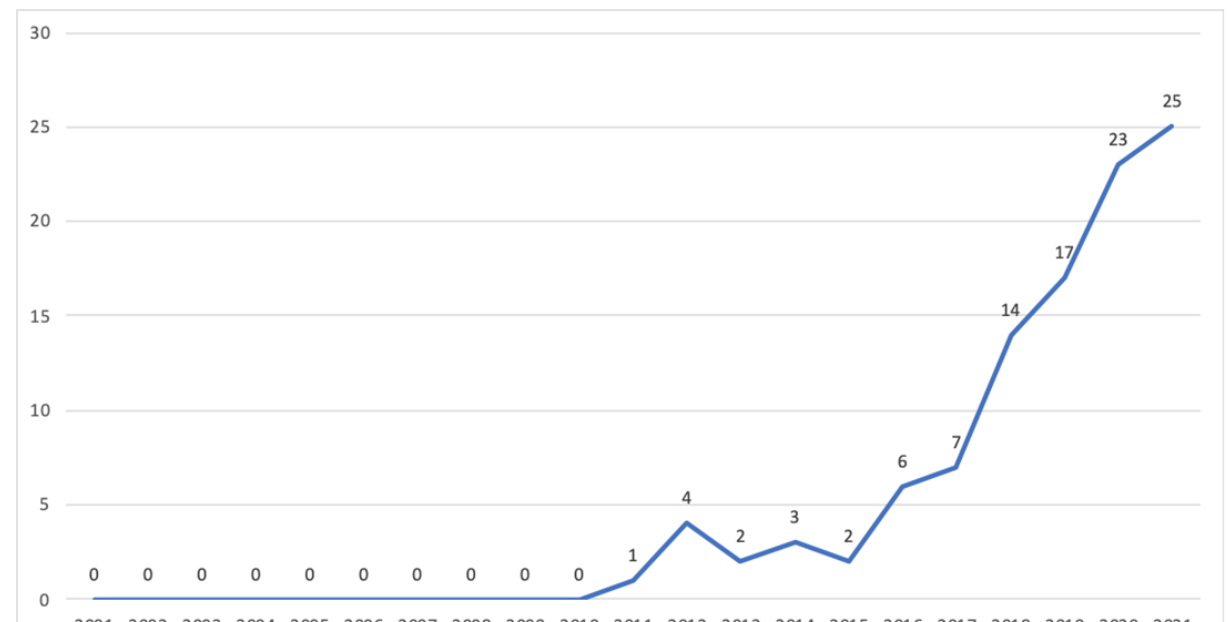
Figure 3. Number of studies published by year (n = 104).